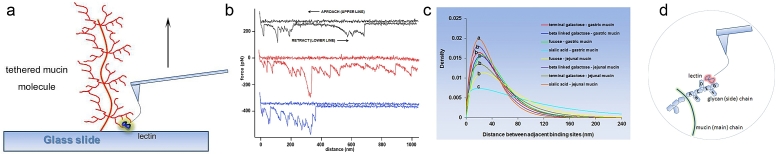
AFM measurement of the glycan distribution on mucin. (a) Schematic diagram of the technique. (b) Three examples of force spectra data. (c) Mathematically modelled fitting of the measured glycan distributions in two different mucin phenotypes. (d) Schematic diagram of antennae composition.